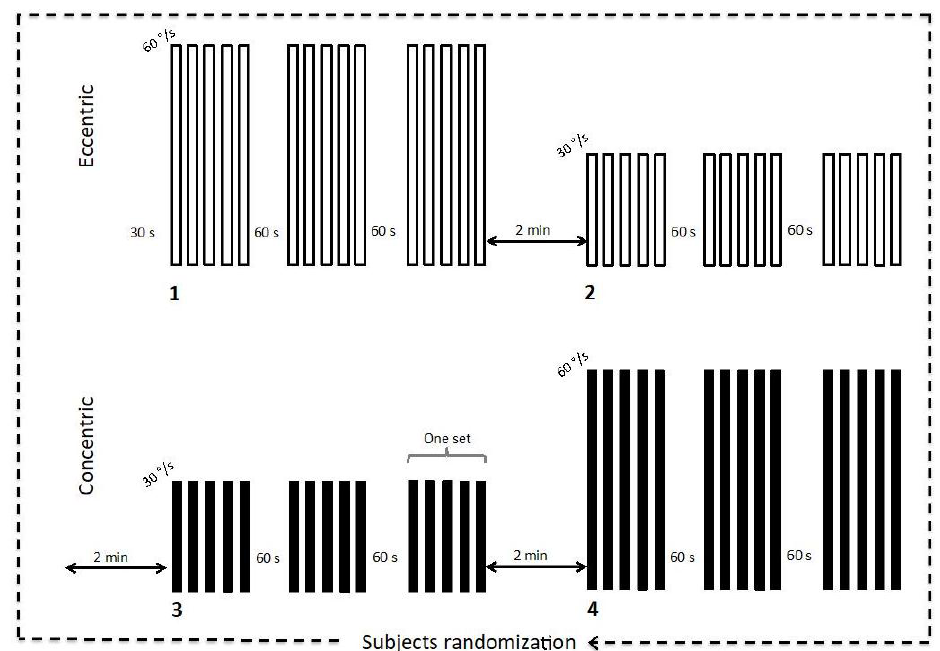
Figure 1. Experimental protocol. The order of the 4 experimental conditions was randomized and three sets of 5 consecutive movements were performed by condition (i.e., eccentric and concentric at angular velocities of 30°/s and 60°/s).